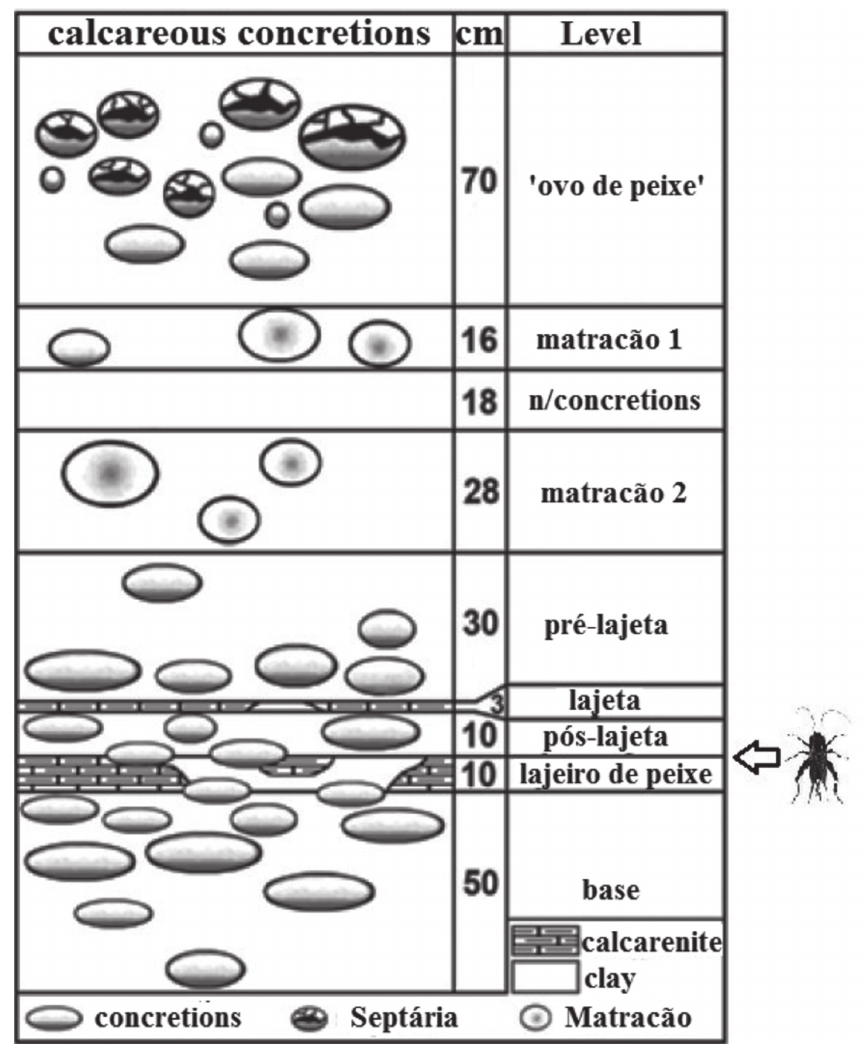
Figure 2 - Schematic profile of the distribution of the calcareous concretions and the location of the fossil finding, modified from Saraiva et al.